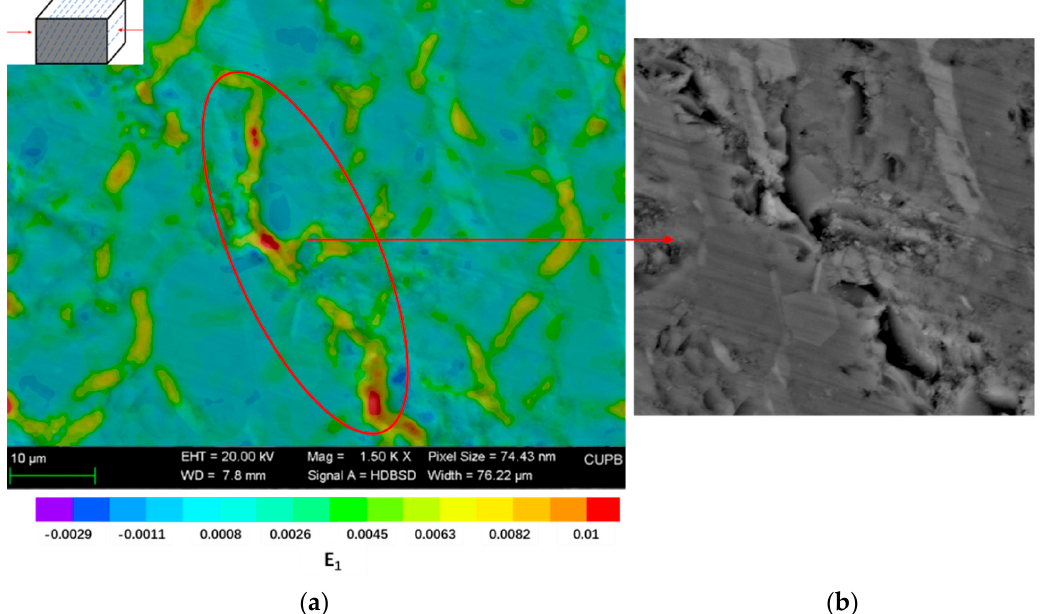
Figure 5. Microstructure deformation when the bedding angle is 60°: ( a ) E 1 cloud chart; ( b ) Zoomed- in microcracks in the circled region.